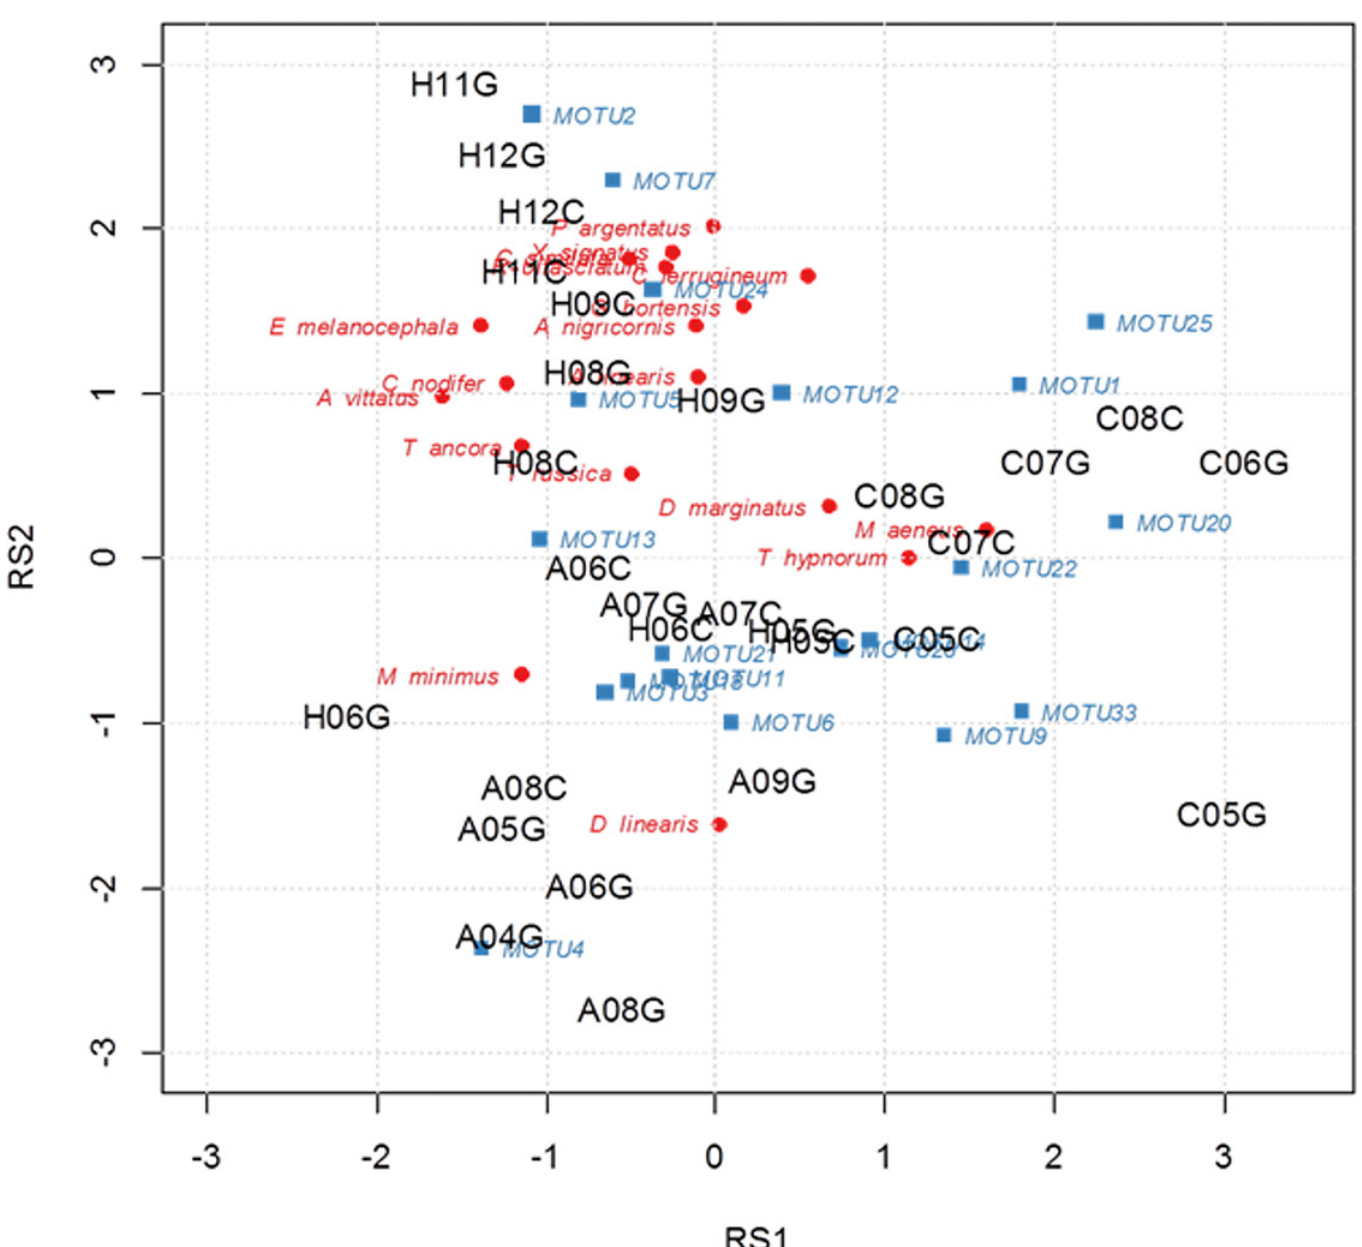
Fig 3. Co-inertia analysis based on species found at least in three samples. The data sets of beetles and fungi produced two representations of the sites in two hyperspaces. Analysis aims at maximising inertia in each hyperspace. Only extreme species are plotted. A = Swabian Alb (AEW plots), H = Hainich- Dün (HEW plots), C = Schorfheide-Chorin (SEW plots). The letter at the end of the study plot abbreviation indicates whether sample was collected from the canopy (C) or the ground